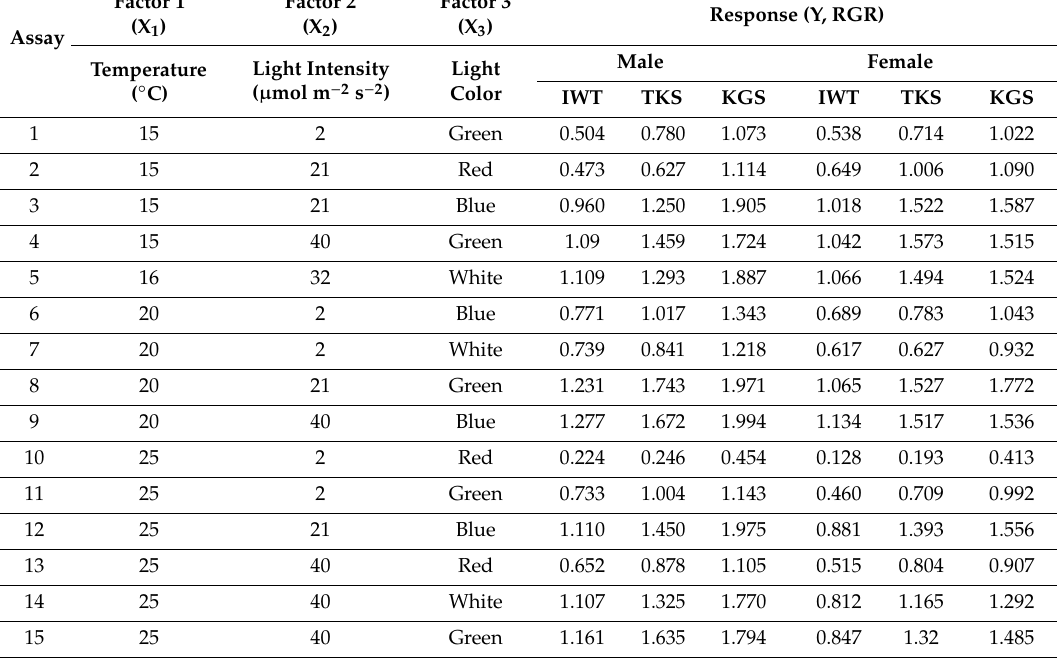
Results of growth experiments for male and female gametophytes of Undaria pinnatifida and the observed response variables (RGR, relative growth rate day − 1 ). The variables matrix was decided following the design protocol (see Materials and Methods) IWT—Iwate, TKS—Tokushima,